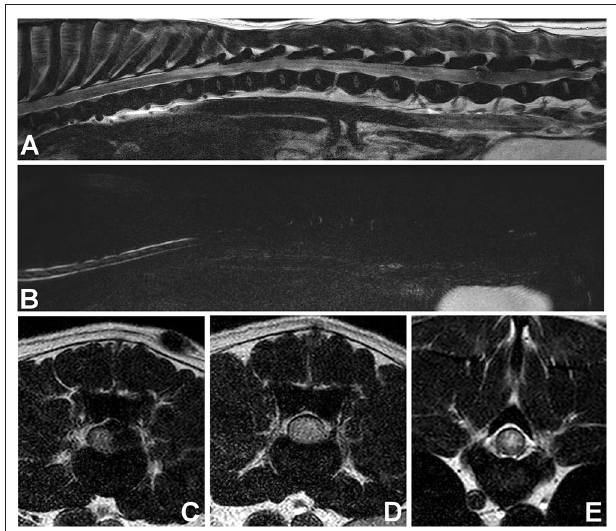
FIGURE 7 | Images of female spayed, 13-year-old Cocker Spaniel with an acute onset of paraplegia. (A) Sagittal T2W image showing a large area of diffuse spinal cord hyperintensity. (B) Sagittal HASTE image showing diffuse spinal cord swelling. (C) Transverse T2W image at the L5-6 level showing lateralized spinal cord compression and spinal cord hyperintensity. (D) Transverse T2W image at the L3-4 level showing diffuse spinal cord hyperintensity and apparent swelling. (E) Transverse T2W image at T9-10 level showing centrally located spinal cord hyperintensity. Myelomalacia and intervertebral disc extrusion at L5-6 were confirmed at post-mortem